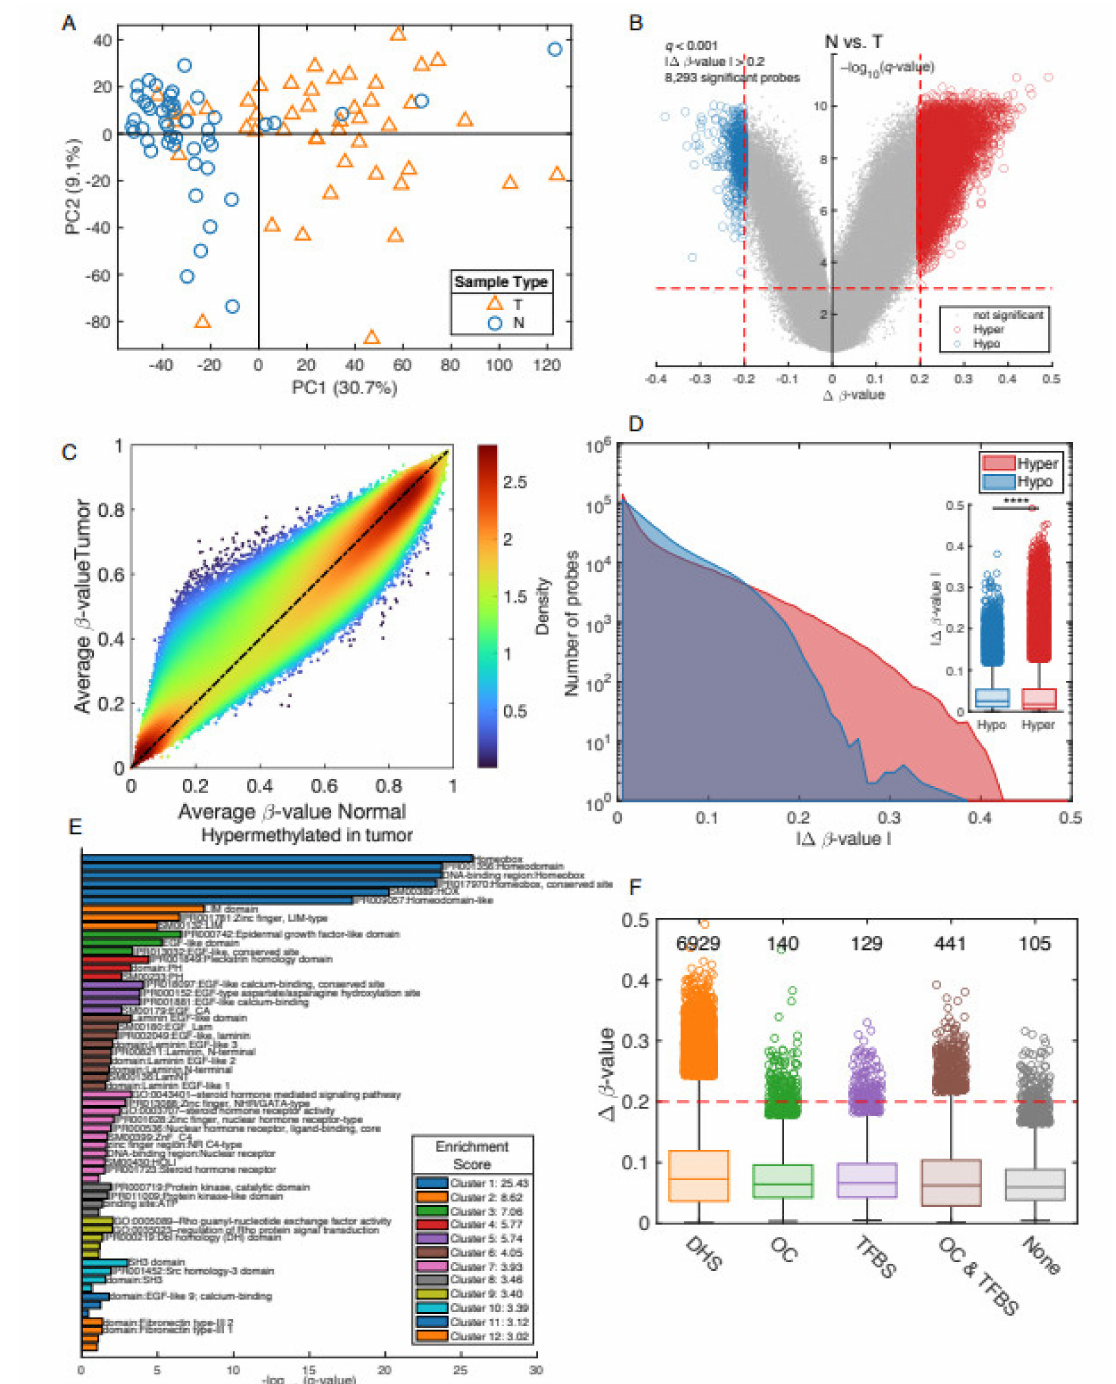
Figure 1. Analysis of tumor vs. normal tissues. The two first principal components in a PCA model using all 49 tumor and 49 adjacent normal samples and all CpG-probes ( n = 807,583) separates normal (blue circles) and tumor (orange triangles) tissues from each other ( A ). A volcano plot comparing tumor vs. normal tissues with ∆ β -value on the x -axis and FDR corrected p -value, − log 10 ( q -value), on the y -axis ( B ). Blue circles indicate significant hypo-methylated CpG-probes and red circles hyper- methylated CpG-probes. Scatter density graph of average β -value for tumor samples vs. normal samples ( C ). Histogram comparing the number of hypo- and hyper-methylated probes ( D ). Enriched gene-sets for hyper-methylated probes using DAVID ( E ). Comparing the ∆ β -value for significant hyper-methylated CpG-probes ( F ). DNase Hypersensitivity CpG-probes (DHS), Open Chromatin probes (OC), Transcription factor binding sites (TFBS). **** p <